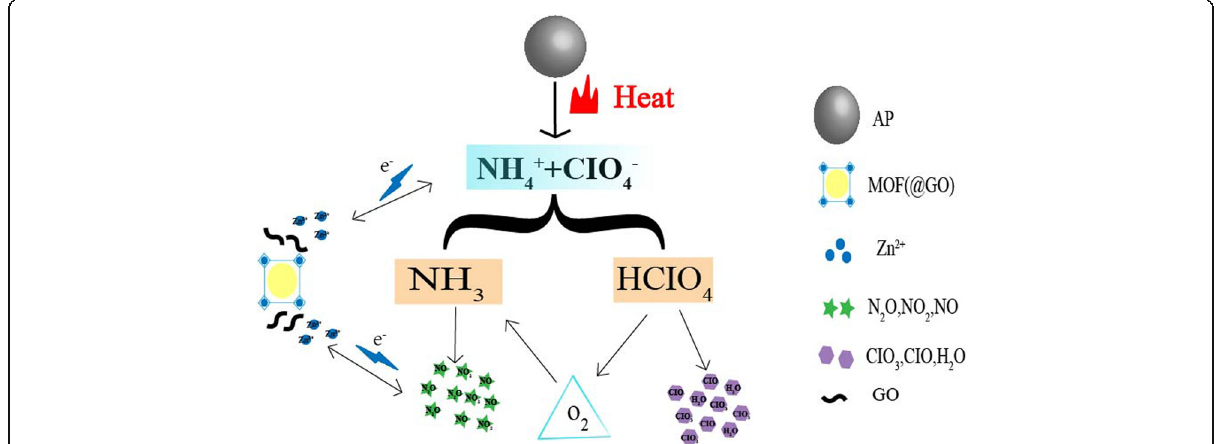
Fig. 11. Mechanism diagram of AP/(GO@)MOF thermal decomposition